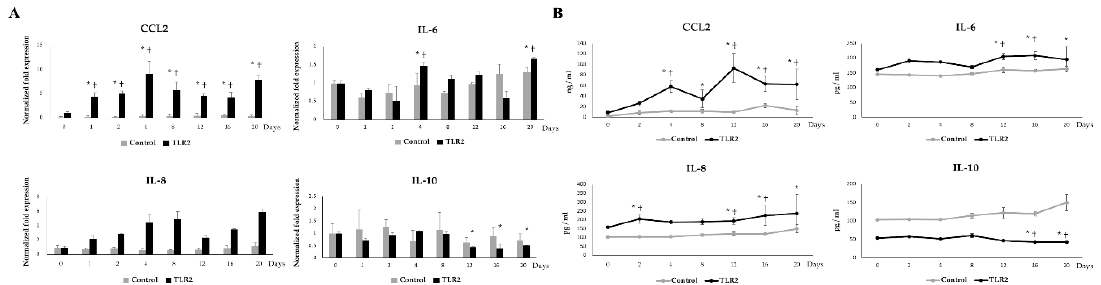
Figure 8. TLR2 mediated adipokine production in adipocytes. The figure displayed the TLR2 mediated mRNA expression ( A ) and protein concentration ( B ) of CCL2, IL-6, IL-8, IL-10 in the adipocytes at different time points of 20 days of adipogenesis. Data shown are the mean ± SD of three independent experiments performed in triplicates. The ‘*’ indicated statistical differences when compared with day 0, and ‘†’ indicated statistical differences when compared with control group at the same time point, both at the significance level of p < 0.05.